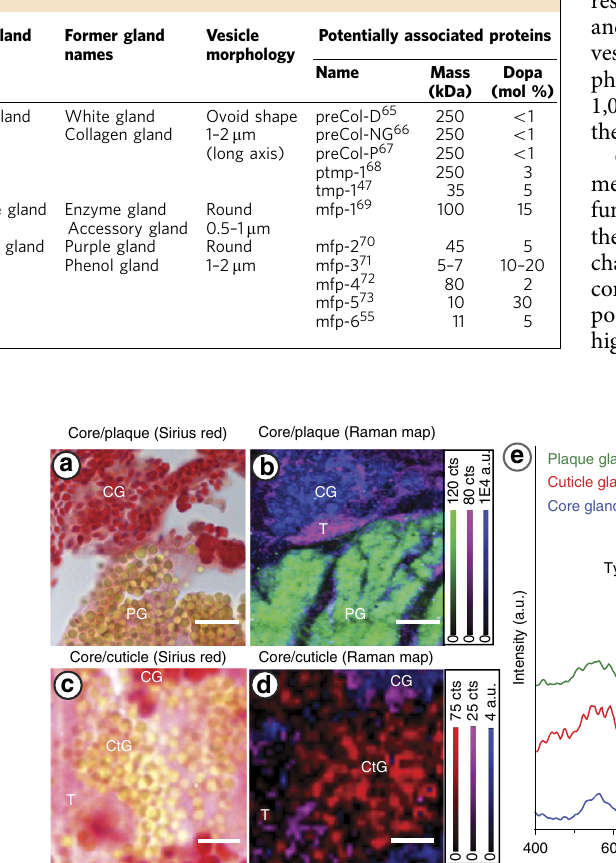
Table 1 | Mussel foot glands and protein contents.